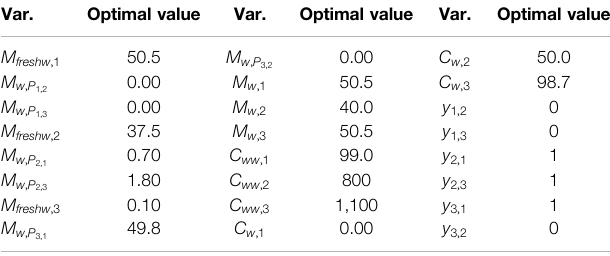
TABLE 9 | Values for the decision variables. Var.